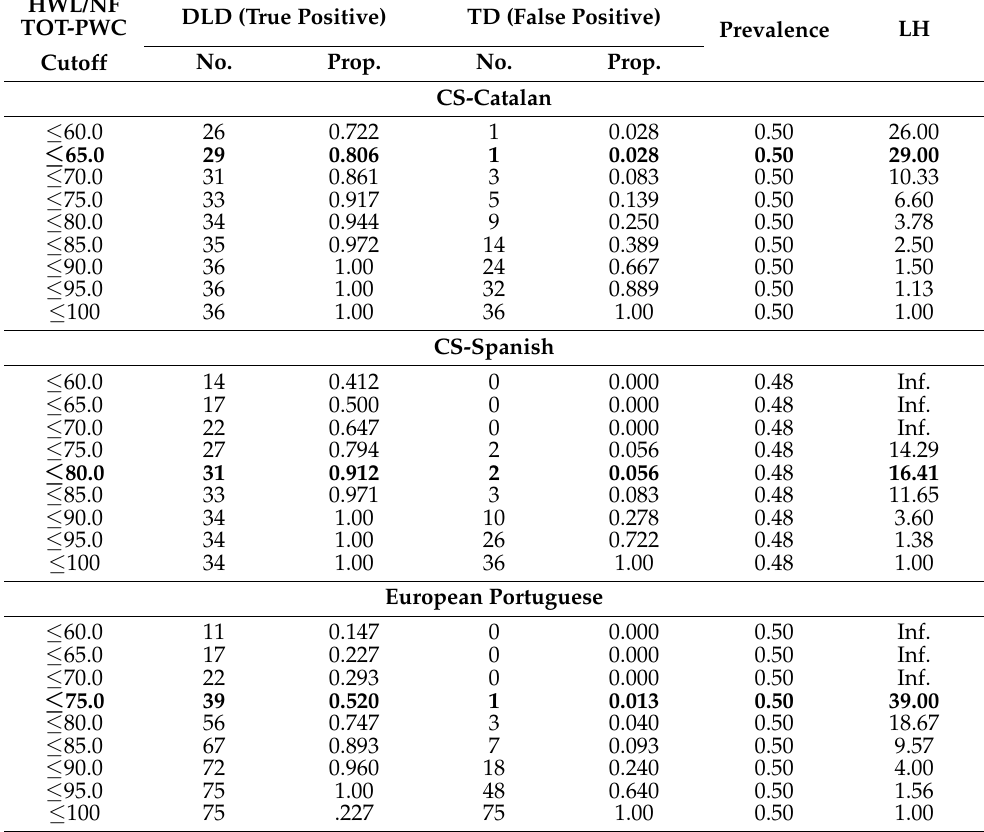
Table 12. The number and proportion of children with a positive test result (ruling in disorder), prevalence, and likelihood ratio (LH) for each of the cutoff values based on total word percentage correct (TOT-PWC) for HIGH wordlikeness (HWL) nonwords for Catalan and Portuguese NRT and HIGH nonword frequency (HNF) nonwords for Spanish NRT for the Catalan–Spanish (CS) and European Portuguese (EP) children with developmental language disorder (DLD) and typically developing (TD) controls. HWL/NF DLD (True Positive) TD (False Positive) TOT-PWC Prevalence LH Cutoff No. Prop. No. Prop. ≤ 60.0